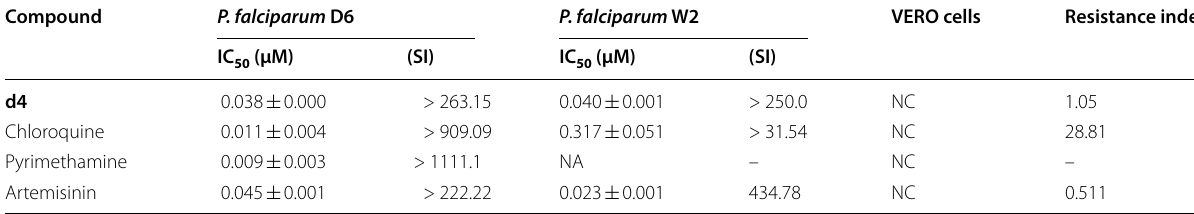
Table 33 In vitro antimalarial activity of AQ-furfural-2-carbaldehyde-pyrimidine hybrids